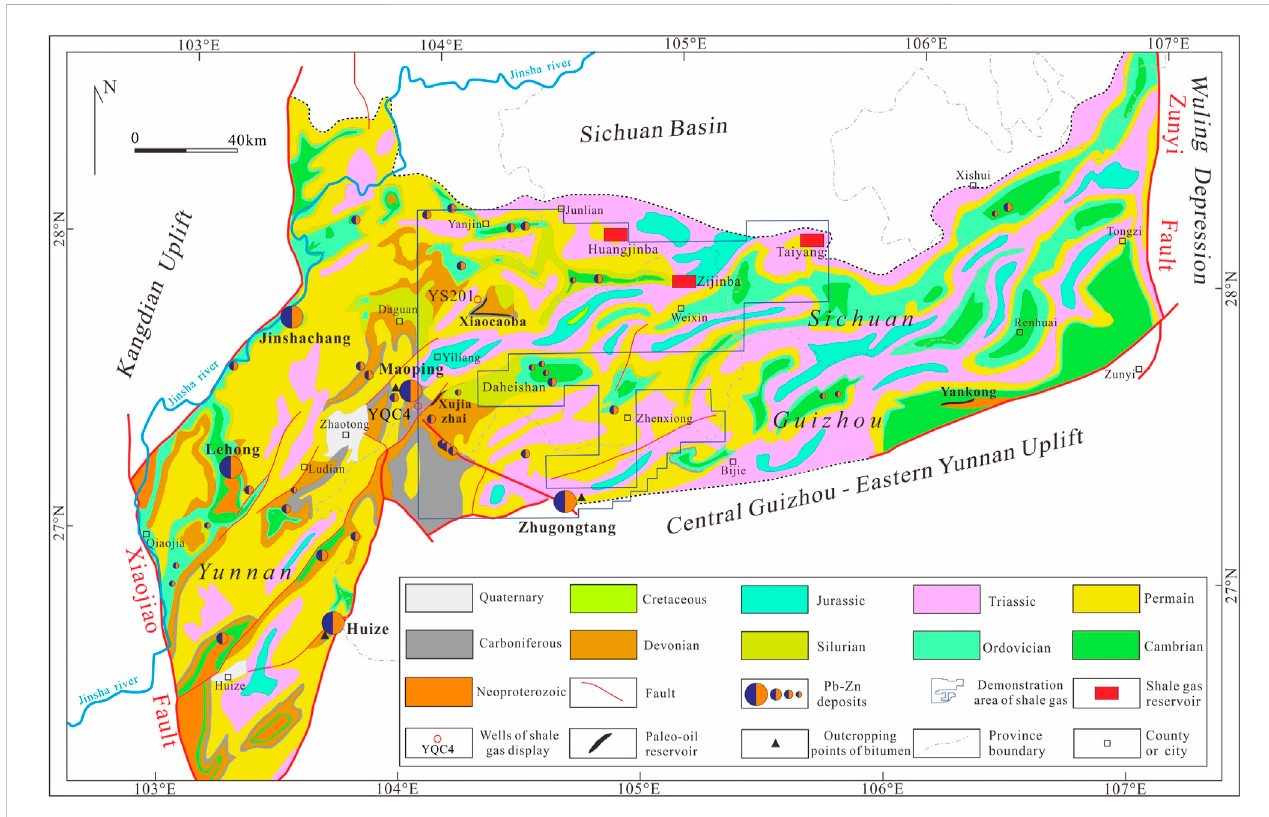
FIGURE 1 Distribution map of Pb – Zn deposits, shale gas and paleo-oil reservoirs in the northern Yunnan – Guizhou